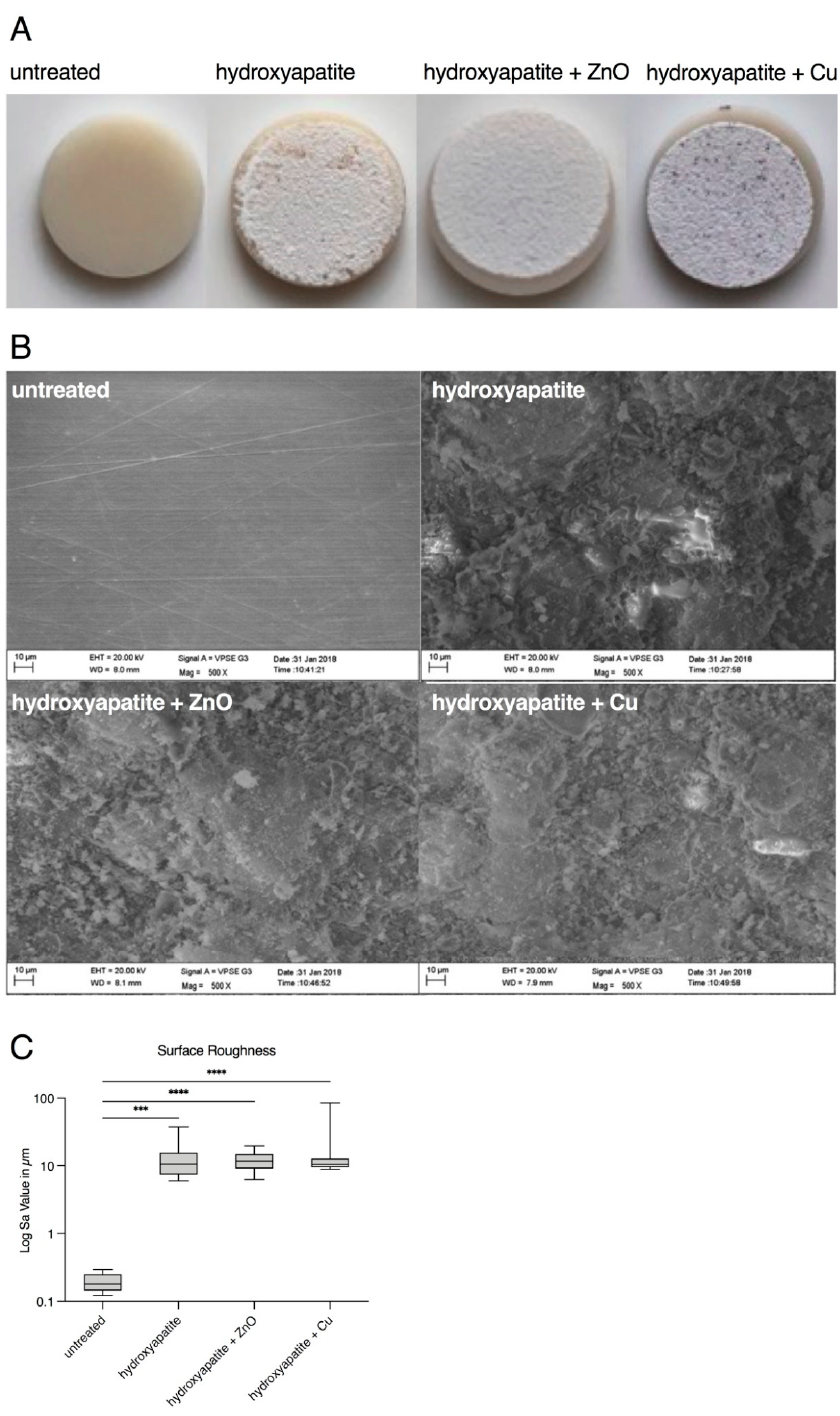
Figure 2. Morphology of specimen surfaces before cell cultivation. ( A ) Photos of specimens. From left to right: untreated, coated with hydroxyapatite, coated with hydroxyapatite + ZnO, and coated with hydroxyapatite + Cu. ( B ) SEM images of specimen surfaces (500 × magnification). UL: untreated; UR: coated with hydroxyapatite; LL: coated with hydroxyapatite and zinc oxide (ZnO); LR: coated with hydroxyapatite and copper (Cu). ( C ) Surface roughness (Log Sa values in µ m) of untreated and plasma-spayed surfaces. Statistically relevant differences ( p < 0.05) were found between untreated and treated specimens. *** p < 0.0005; **** p <